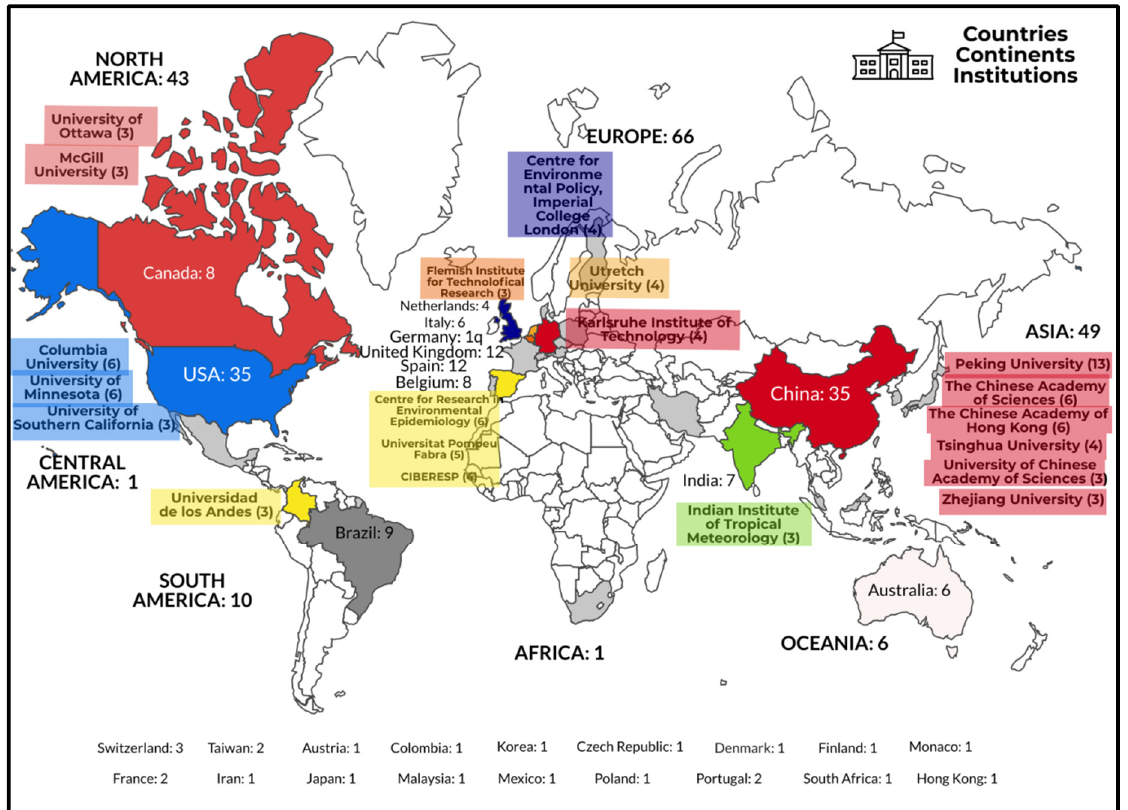
Figure 7. Global geographical distribution of publications: number of publications by continent and country, and institutions with the highest number of publications.